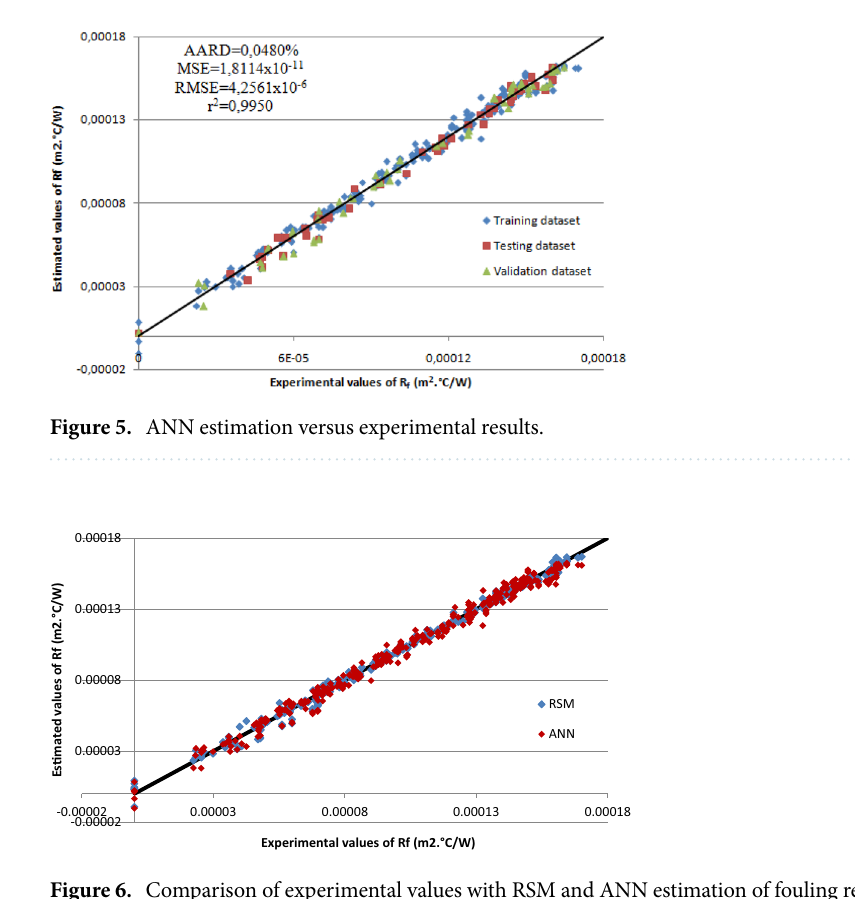
Figure 6. Comparison of experimental values with RSM and ANN estimation of fouling resistance.